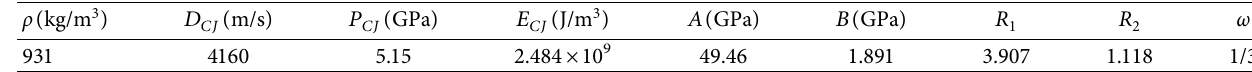
Table 1: Material parameters of ANFO explosive [35].